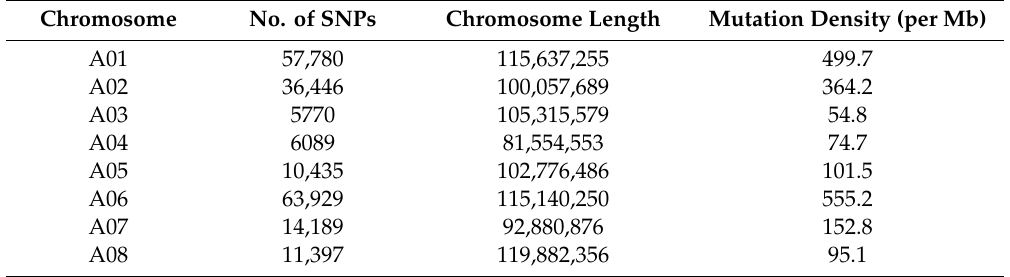
Table 1. Genome-wide EMS-induced SNP numbers and mutation density in